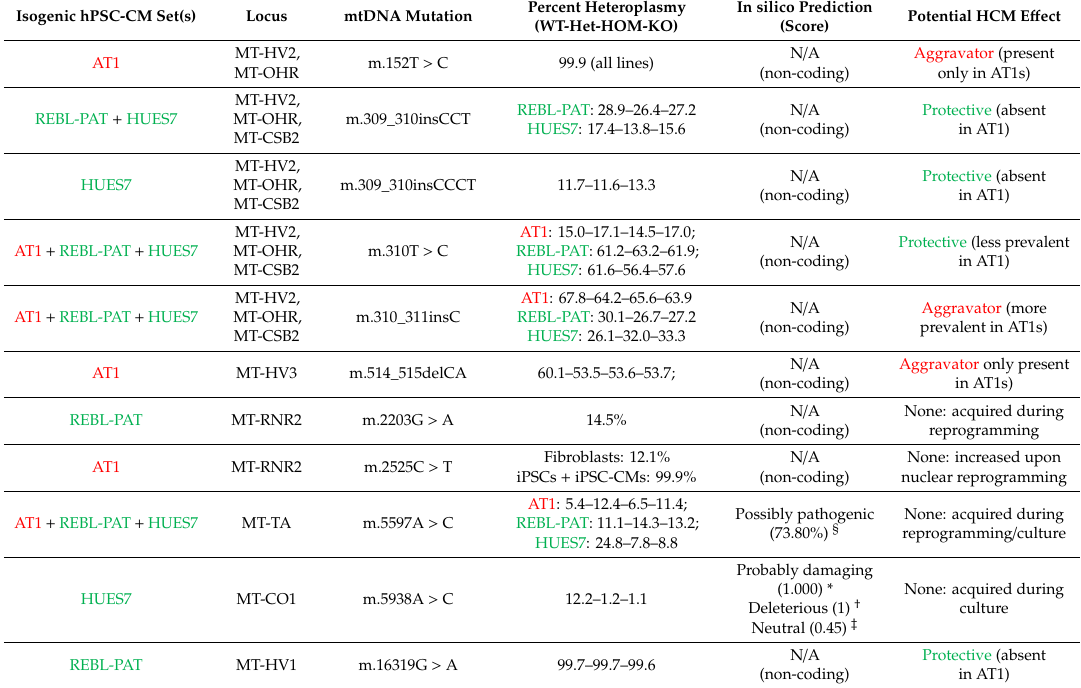
Table 1. mtDNA variants identified by NGS in p.R453C- β -MHC isogenic lines used for HCM modeling (WT, healthy; het, heterozygous; HOM, homozygous; KO, knockout). In silico pathogenicity prediction algorithms used: § MitoTIP; * Polyphen-2; † CAROL; ‡ APOGEE. Phenotypically severe hPSC-CM line is highlighted in red and less severe ones in